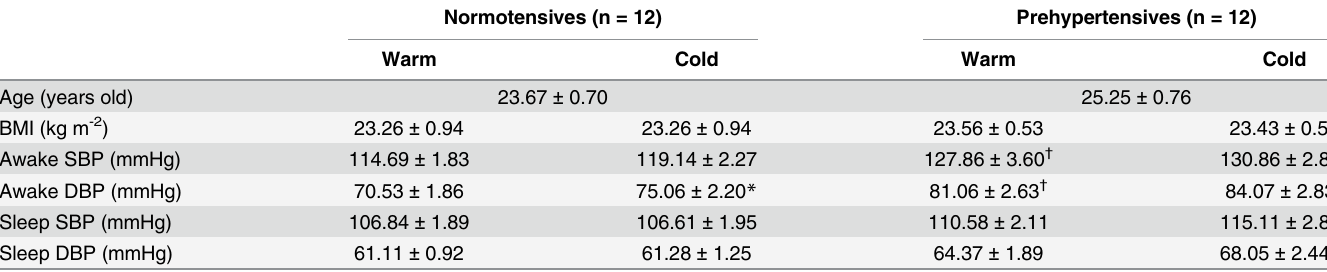
Table 1. General measurements during baseline recording under the two ambient temperature